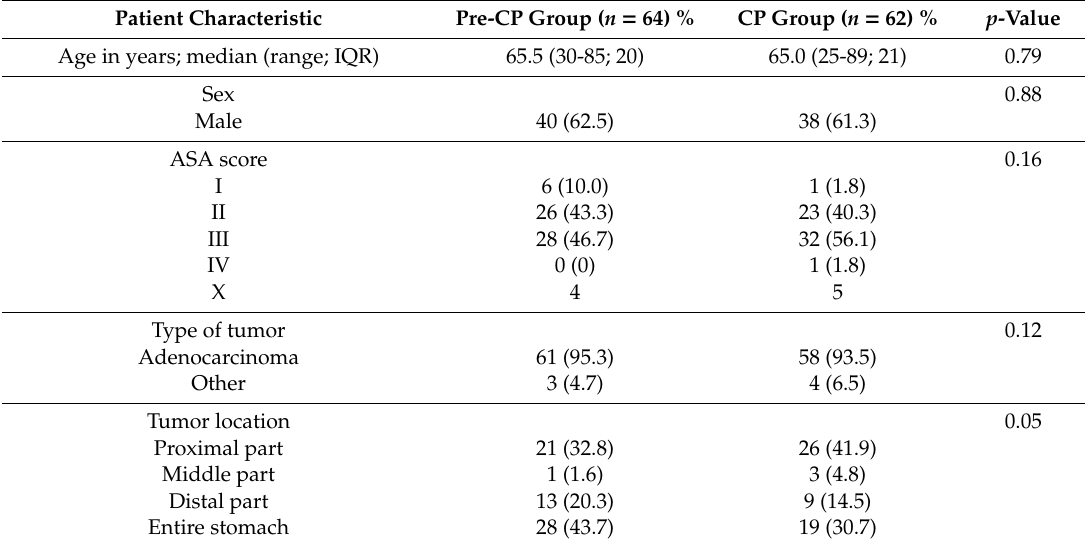
Table 1. Characteristics of the study